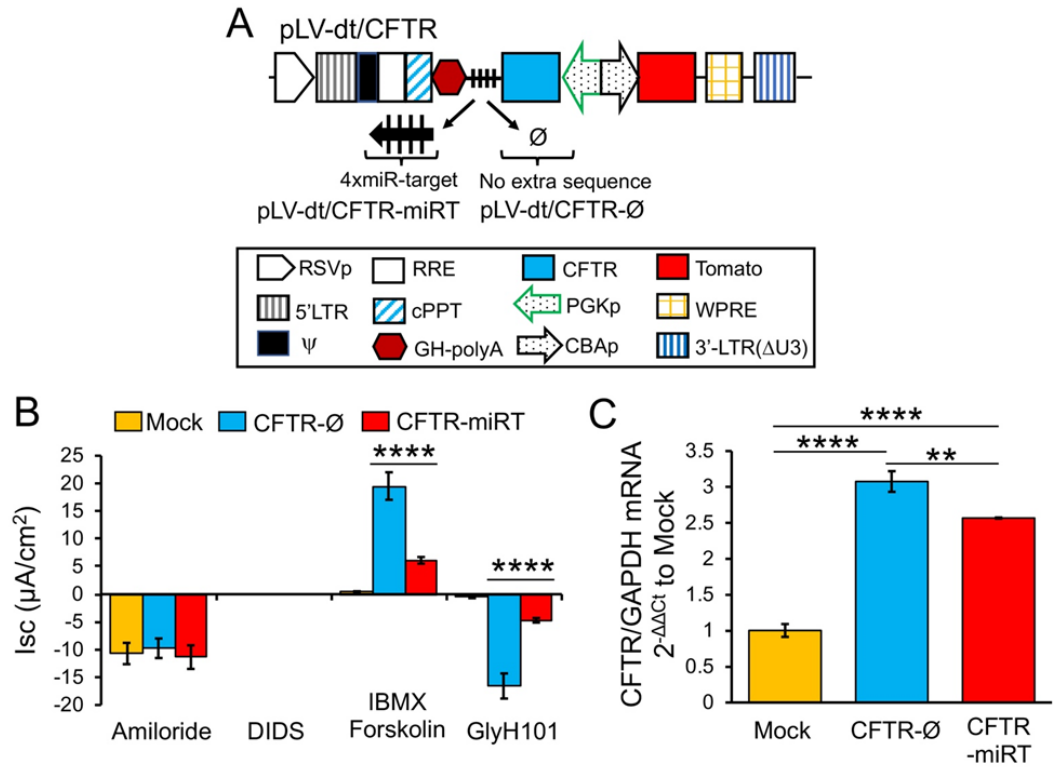
Figure 6. Detargeting CFTR expression in basal cells impacts the level of complementation in CF airway epithelia. ( A ) Diagram of lenti-vector containing CFTR expression cassette in reverse orientation. The PGK promoter (PGKp) drives expression of CFTR with the miR-106b target sequence 4 (4× miR target or mirT) in the 3’UTR. CBA promoter drives expression of Tomato as a reporter gene